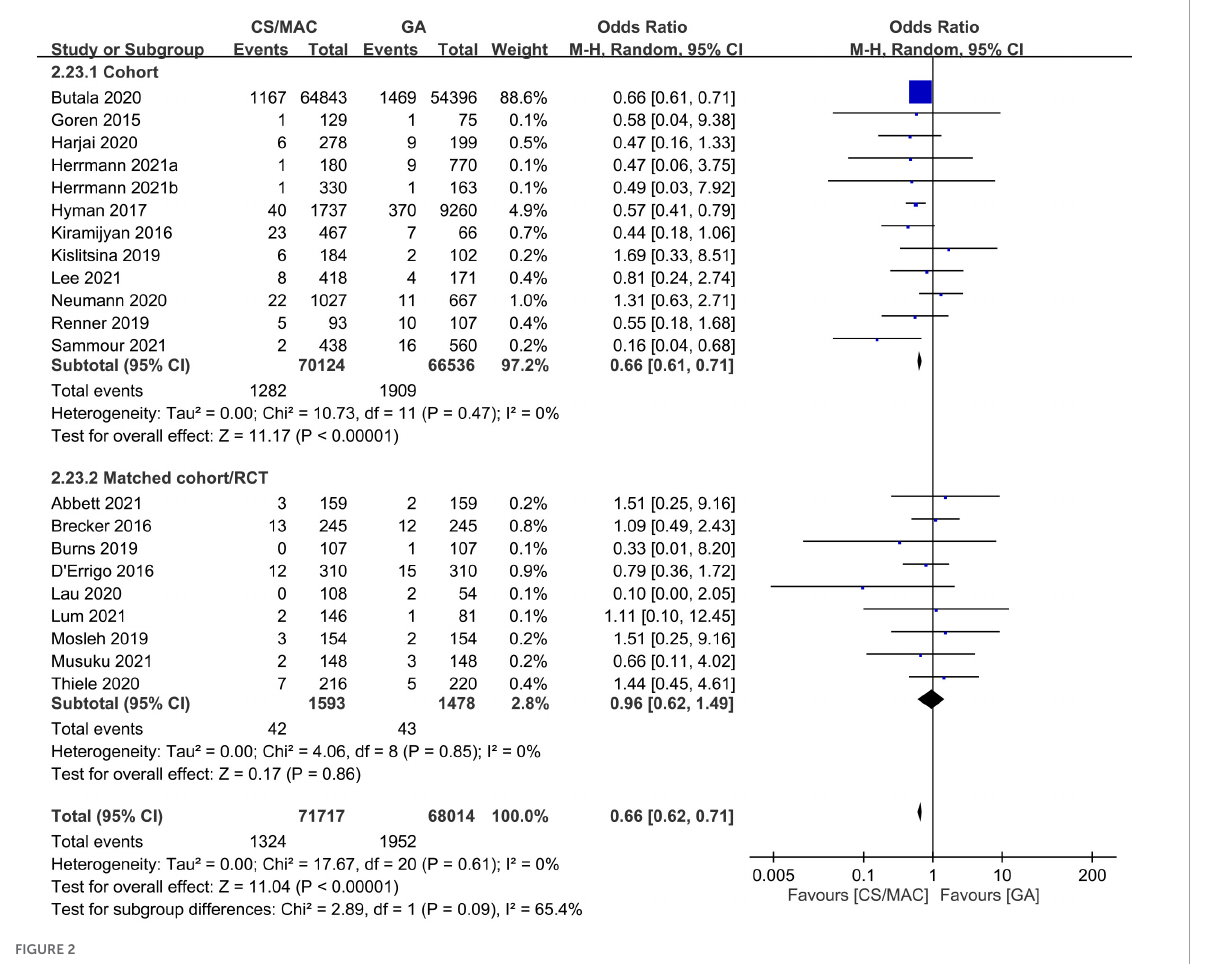
(OR = 0.81, 95% CI: 0.6 to 1.09, p = 0.17, I 2 =